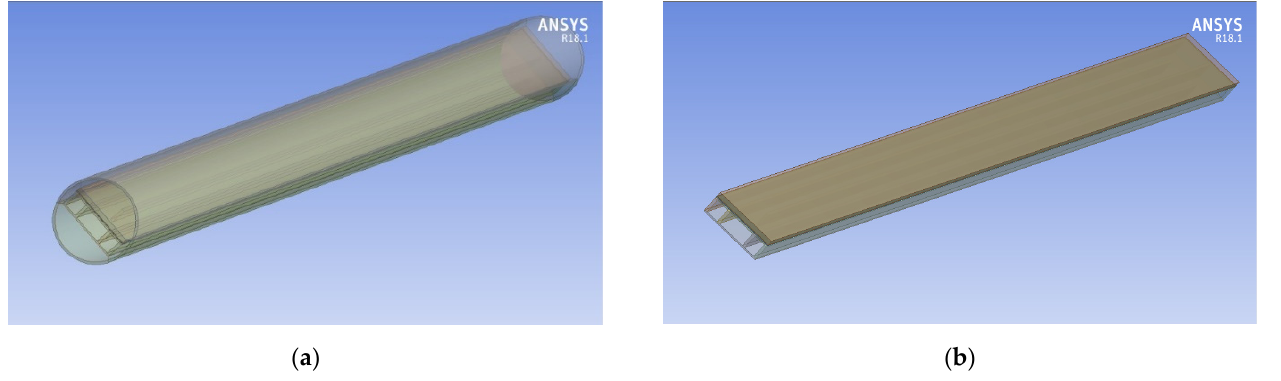
Figure 1. Different PVT systems evaluated in this paper: ( a ) Evacuated PVT and glazed PVT; ( b ) unglazed PVT.